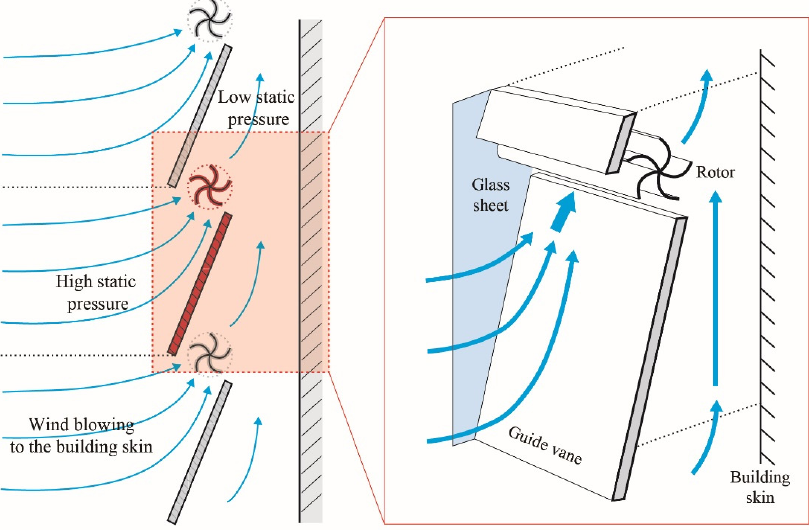
Figure 2. Schematic diagram of the proposed